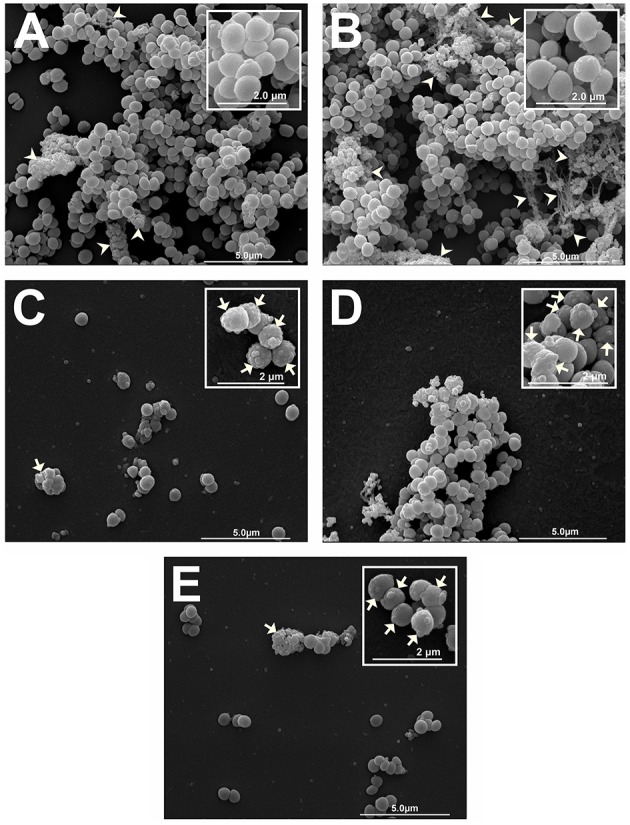
Scanning electron micrograph of antibacterial effect of OEO and bio-AgNP alone and in combination against S. aureus ATCC 25923 (non-MRSA). (A) Untreated control after 30 min incubation. (B) Untreated control after 6 h incubation. (C) Treated cells with OEO at 0.596 mg/mL for 30 min. (D) Treated cells with bio-AgNP at 250 μM for 6 h. (E) Treated cells with combination of OEO and bio-AgNP at 0.298 mg/mL and 125 μM, respectively, for 6 h. Micrographs (A–E) show cell density and exopolysaccharide matrix (15,000 x). Inset images show detail of morphological alterations of treated cells and typical cell morphology of untreated controls (30,000 x). Arrows: morphological changes (surface protrusions) and cellular debris. Arrowheads: exopolysaccharide.